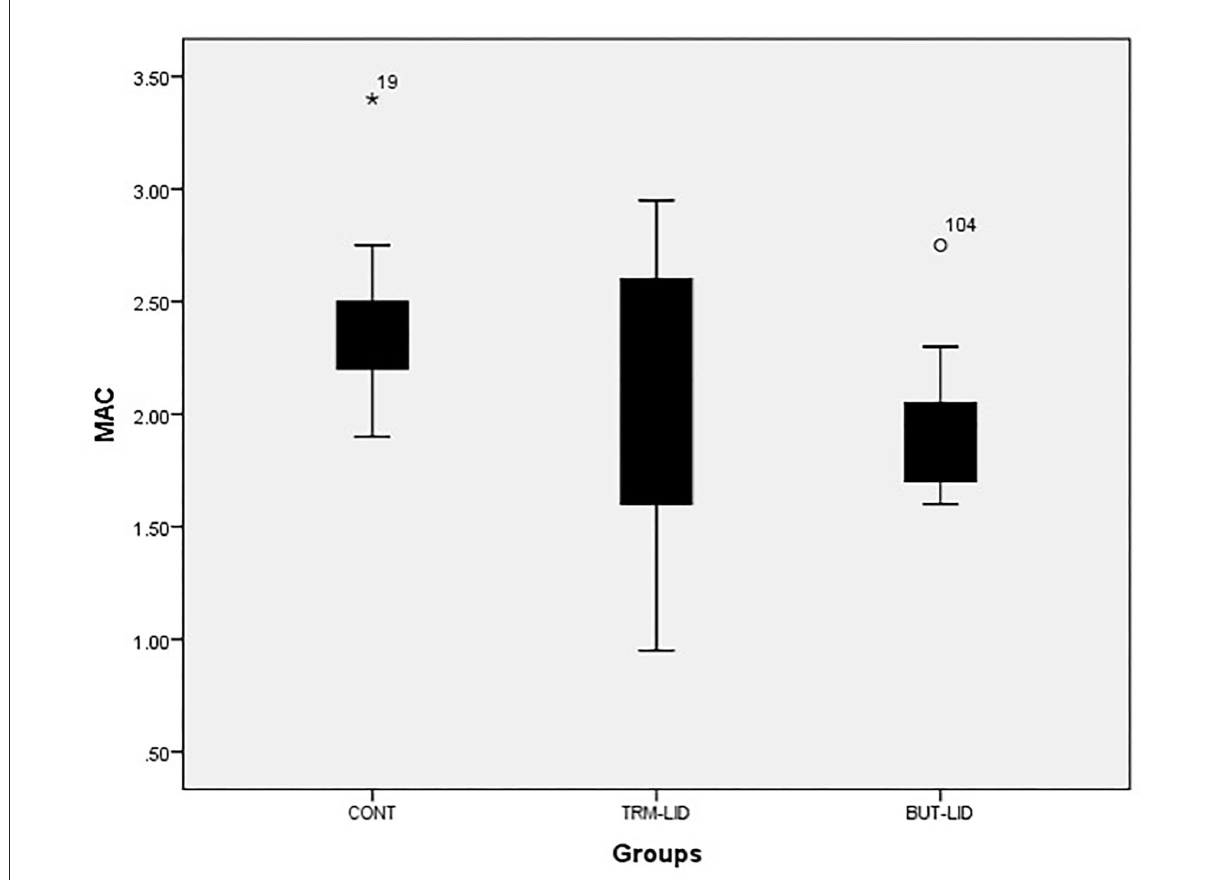
FIGURE1 Mean values of minimum alveolar concentration (MAC) of sevoflurane in control (CONT), tramadol-lidocaine (TRM-LID) and butrophanol-lidocaine (BUT-LID) treatments in dogs.